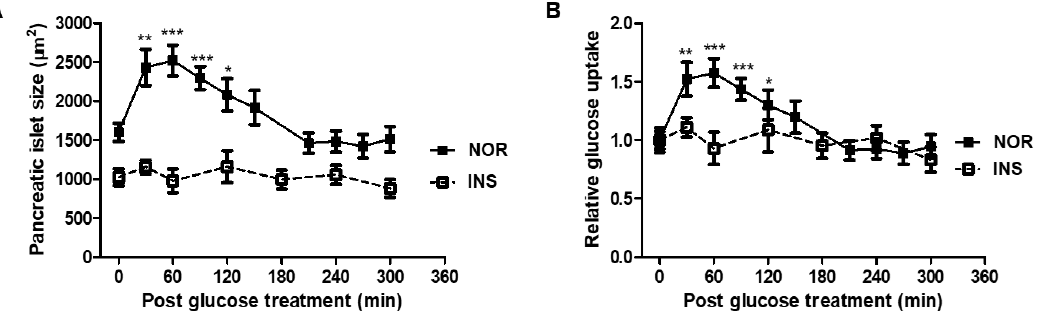
Figure 4. Glucose tolerance test (GTT) in insulin-treated zebrafish. ( A ) Size of pancreatic islet by glucose treatment ( n = 20). (*) p < 0.05, (**) p < 0.01 and (***) p < 0.001; compared to 0 min. ( B ) Relative glucose uptake by glucose treatment ( n = 20). (*) p < 0.05, (**) p < 0.01 and (***) p < 0.001; compared to 0 min.